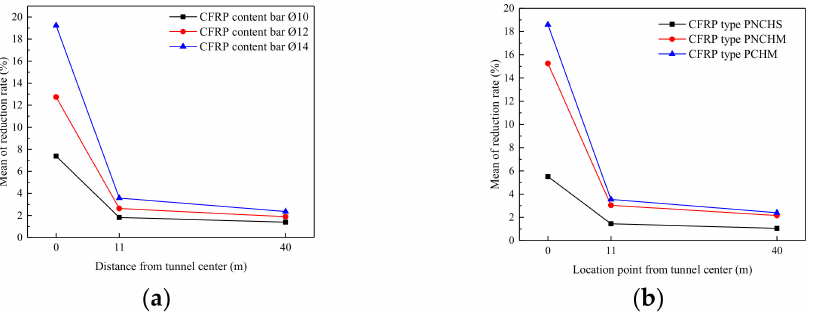
Figure 24. Interaction plot matrix of the reduction rate of the ground vibration at the speed of 100 km/h. ( a ) CFRP content * Distance; ( b ) CFRP Type *